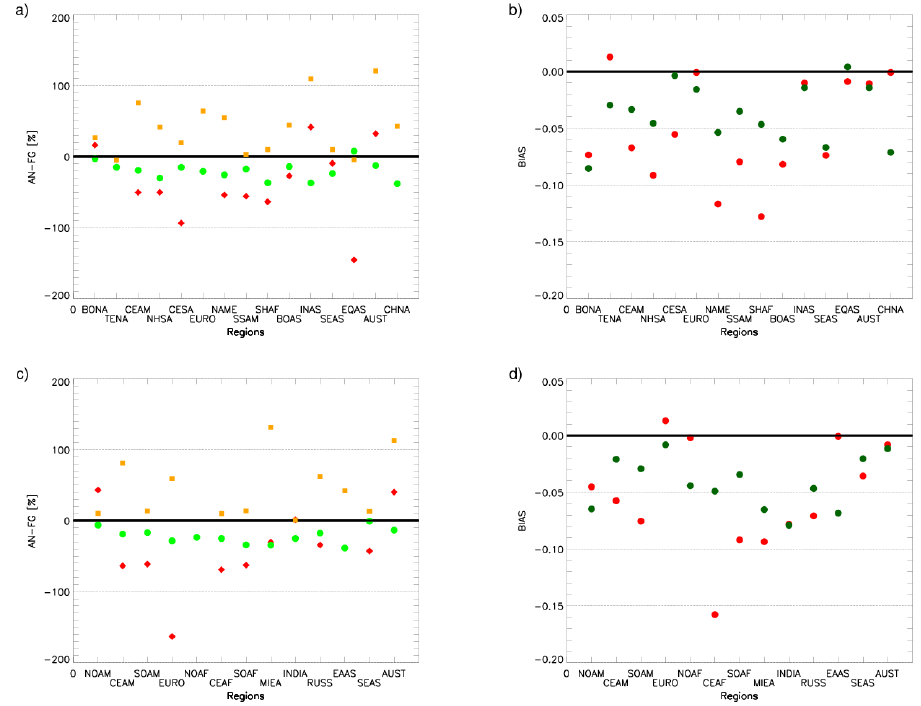
Fig. 2. Total AOD change in RMS error (green circles), mean bias (red diamond) and correlation (orange squares) between FG and AN with respect to MODIS AOD [in %] for (a) biomass burning and (c) industrial regions identified in the x-axis. In addition, bias in AOD [unitless] for FG (red) and AN (green) with respect to MODIS for (b) biomass burning and (d) industrial regions (identified in the x-axis) are illustrated. Regions are presented in Section 2.3 and illustrated in Fig. 1.